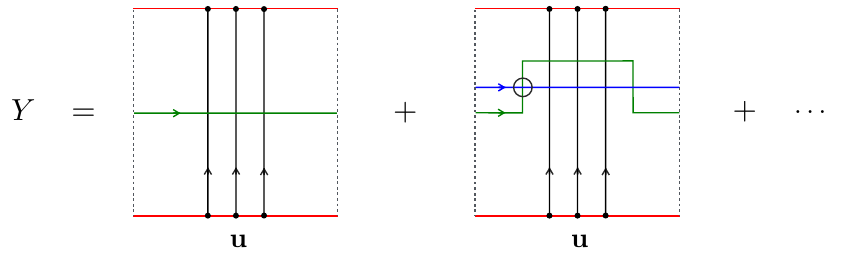
Figure 7 . Low temperature expansion of the Y function. We introduce a probe (the green transversal line winding around the cylinder) by pulling a magnon out of the thermal mirror bath. When the probe rapidity matches with one of the Bethe roots u , we recover the e(cid:11)ect of a real magnon going once around the world. The leading term is controlled by the dressed transfer matrix. At the next order, the probe starts interacting with the excitations in the thermal mirror bath. This interaction is controlled by the mirror scattering kernel, that is, the derivative of the logarithm of the mirror-mirror S-matrix. In the (cid:12)gure, we indicate with a circle the interaction point where a derivative w.r.t. the rapidity of the thermal mirror line (in blue) is